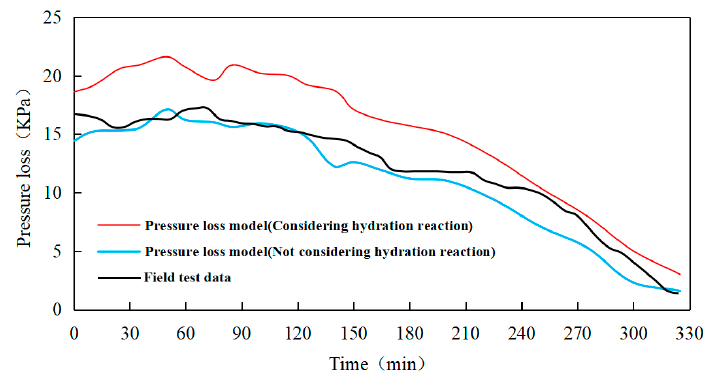
Figure 7. Comparison between the calculated pressure loss and the measured results.